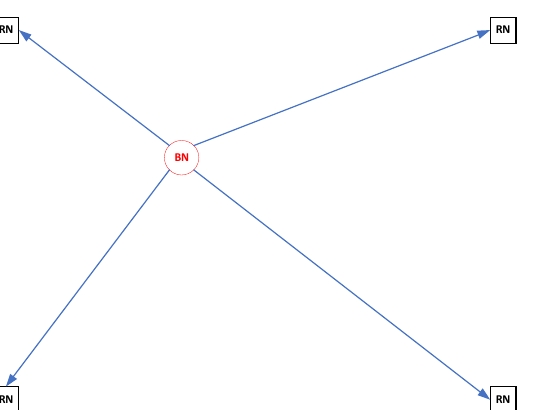
Figure 1. The traditional location technique using one-spot TOA measurements.